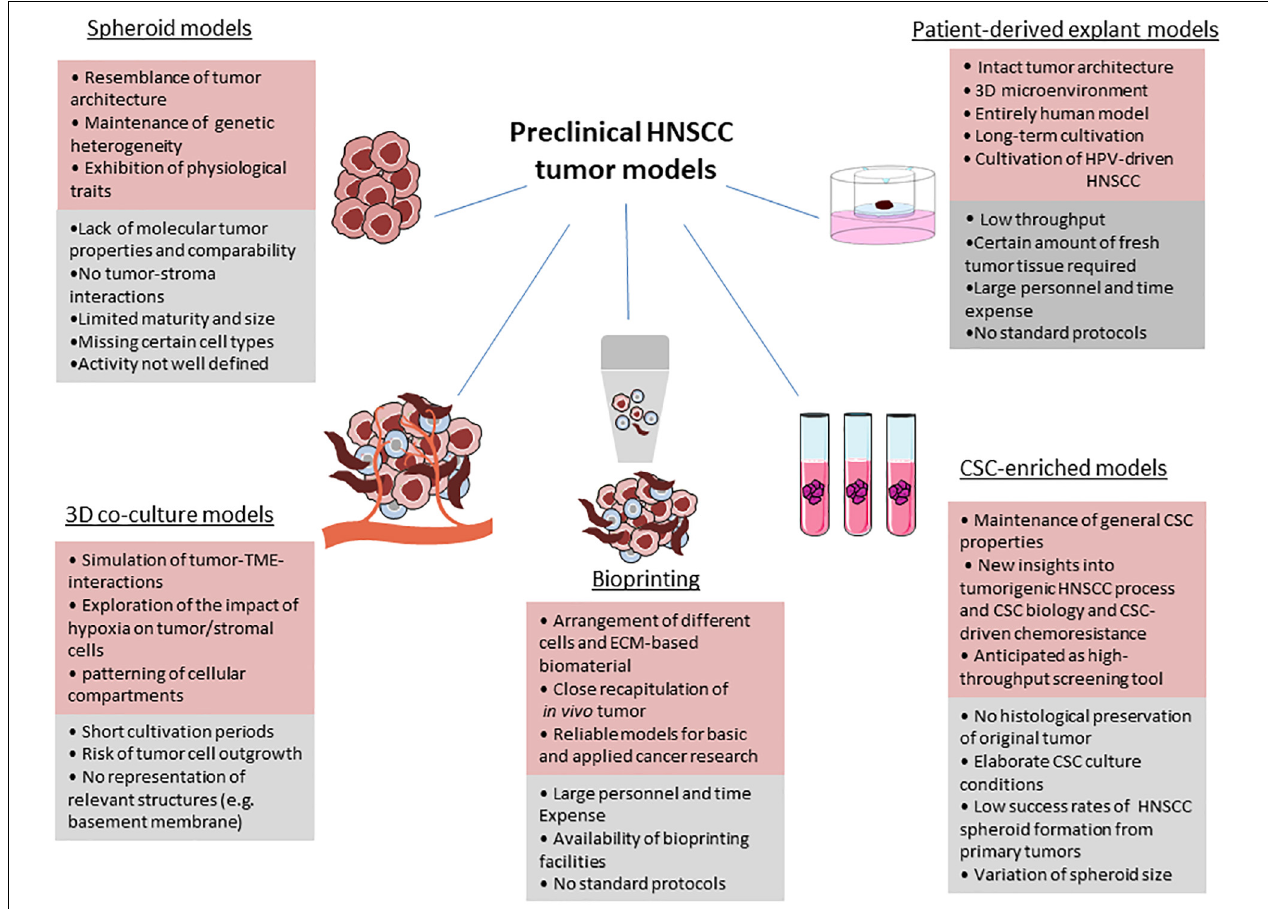
FIGURE 1 | Benefits, limitations and drawbacks of current preclinical HNSCC models. For each model, advantages (red), and limitations (grey) are given. Parts of the figure were drawn by using pictures from Servier Medical Art (http://smart.servier.com/), licensed under a Creative Commons Attribution 3.0 Unported License (https://creativecommons.org/licenses/by/3.0/).